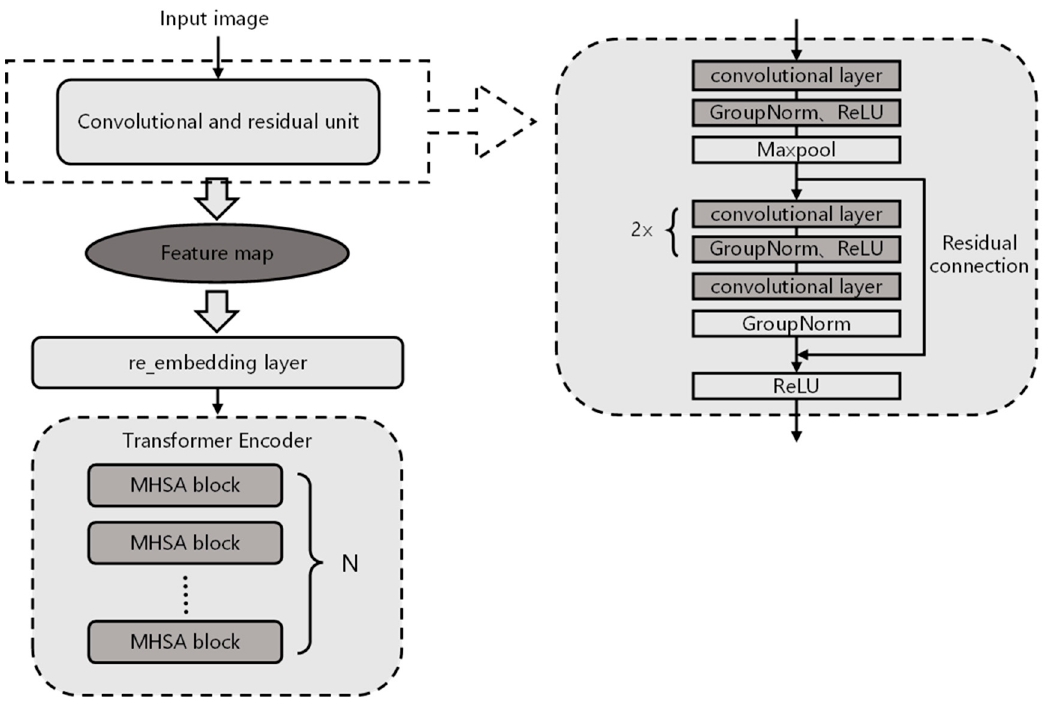
Figure 5. The framework of ReVI based on ViT [22], Transformer [15] and ResNet [11]. Table 1. ReVI main network layers and parameters.